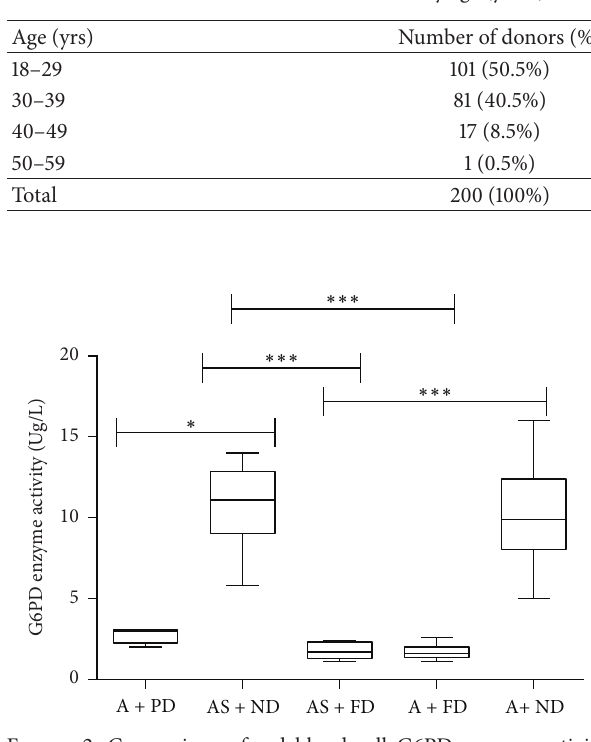
(Figure 2; 𝑝 = ns (AS + ND versus A + ND; AS + FD versus A +